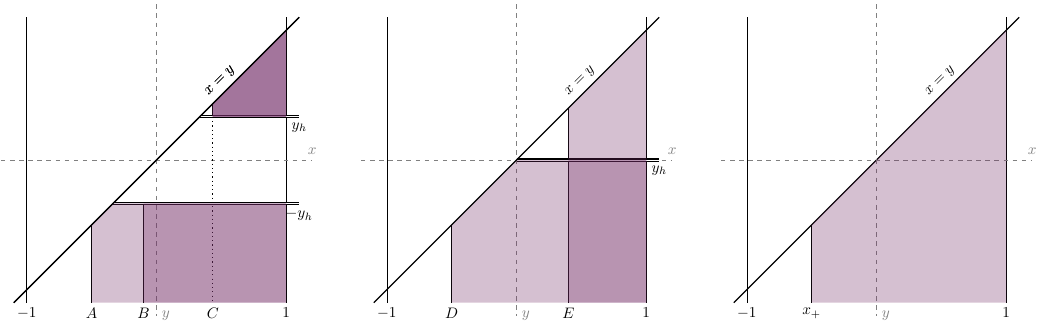
Figure 2 . Coordinate ranges for single-wall solutions constructed from metrics of Class I (with t timelike). Left : three qualitatively distinct solutions are shown for class I rapid , Centre: three for class I saturated , and Right : one for class I slow